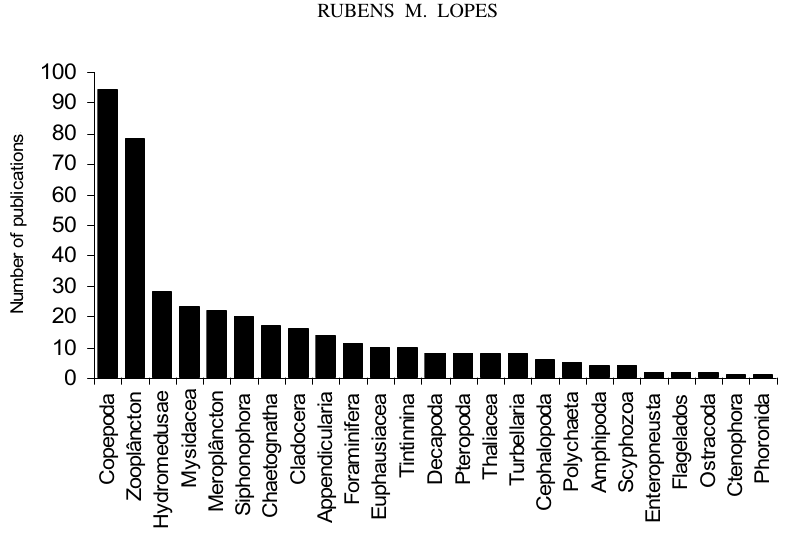
Fig. 2 – Total number of publications (theses included) on several marine zooplankton groups investigated in Brazilian waters (south and southeast continental shelf) since the beginning of the 20 th century. Data from Lopes et al.